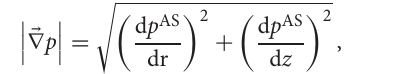
FIGURE 1 | Von Mises equivalent stress in the half-space normalized with the average pressure p 0 assuming ν depth δ : (A) Parabolical indenter, (B) Cylindrical flat punch, (C) paraboloid with a parabolical cup with b / a edge with b / a =